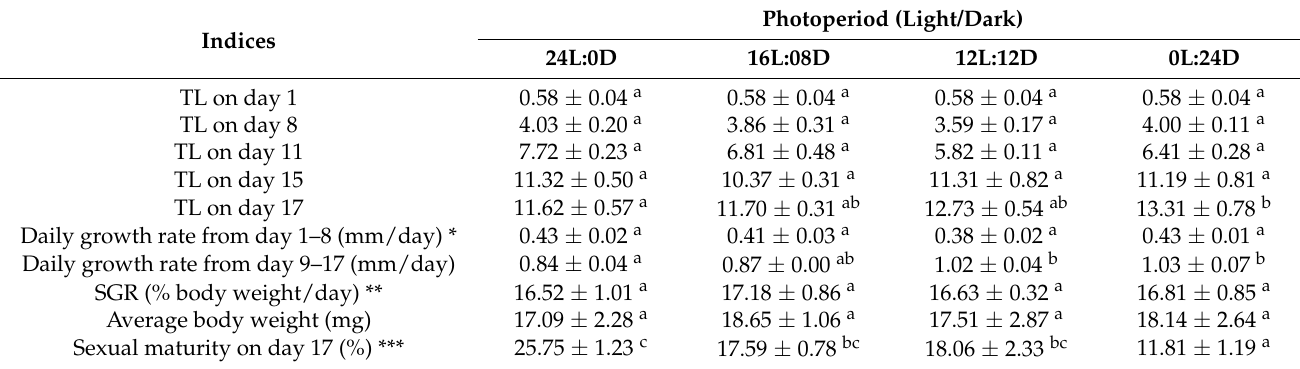
Figure 2. Comparison of survival rate of B. orientalis under different photoperiod regimes (mean ± SD, n = 3). Different superscript letters denote statistically significant differences at each timepoint ( p < 0.05).